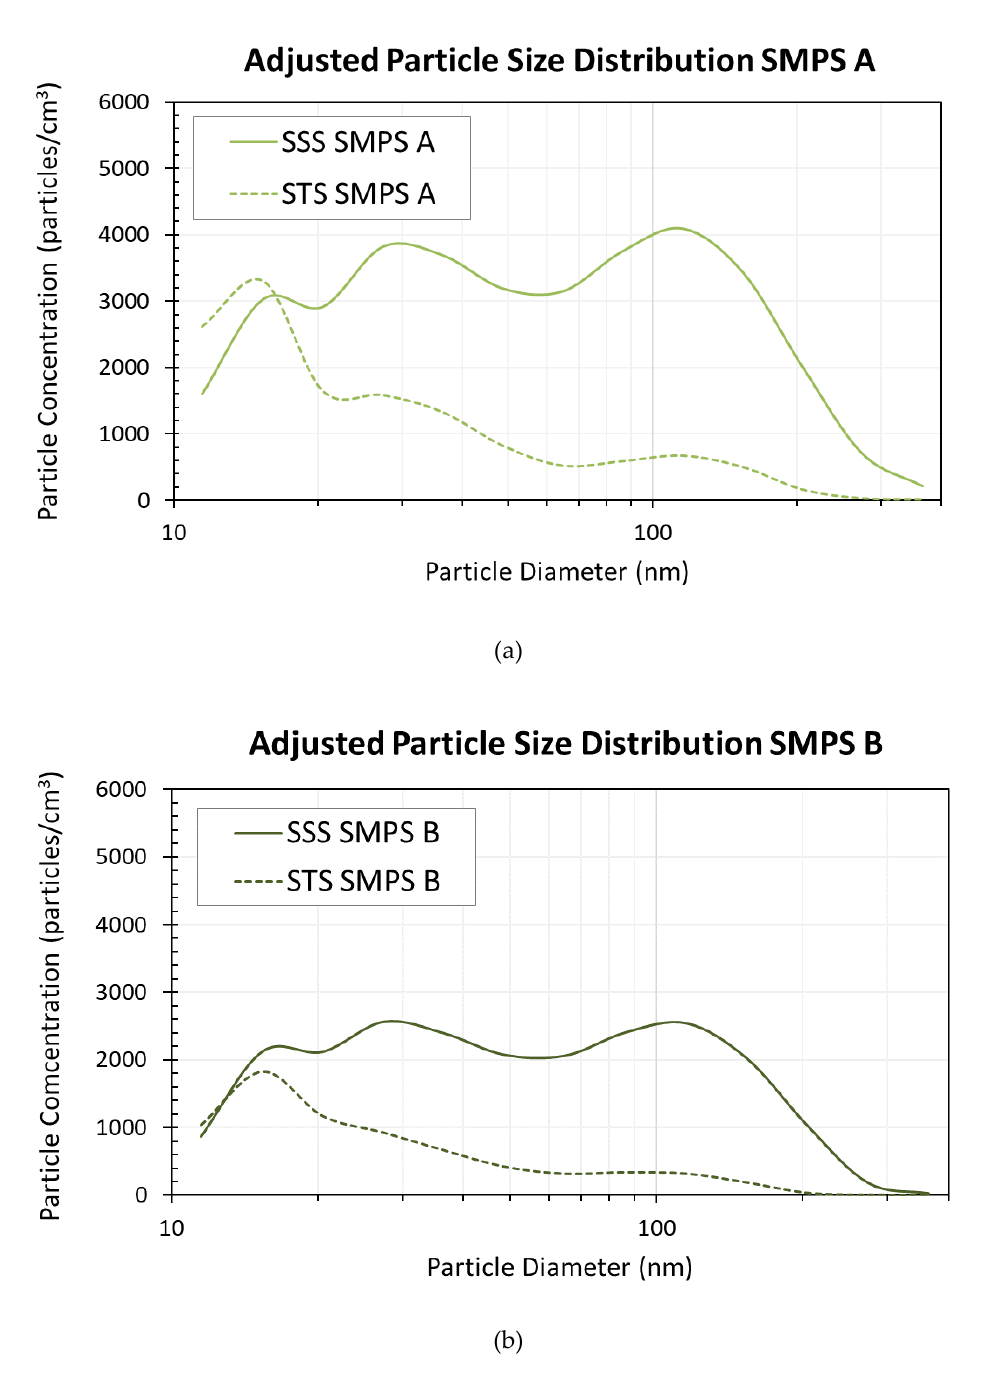
Figure 3. Comparison of SSS and STS aerosolized particle distributions collected by Nanoscan SMPS during the sampling period at locations of ( a ) 15 cm / 6 in. from the source and ( b ) 30 cm / 12 in. from the source.